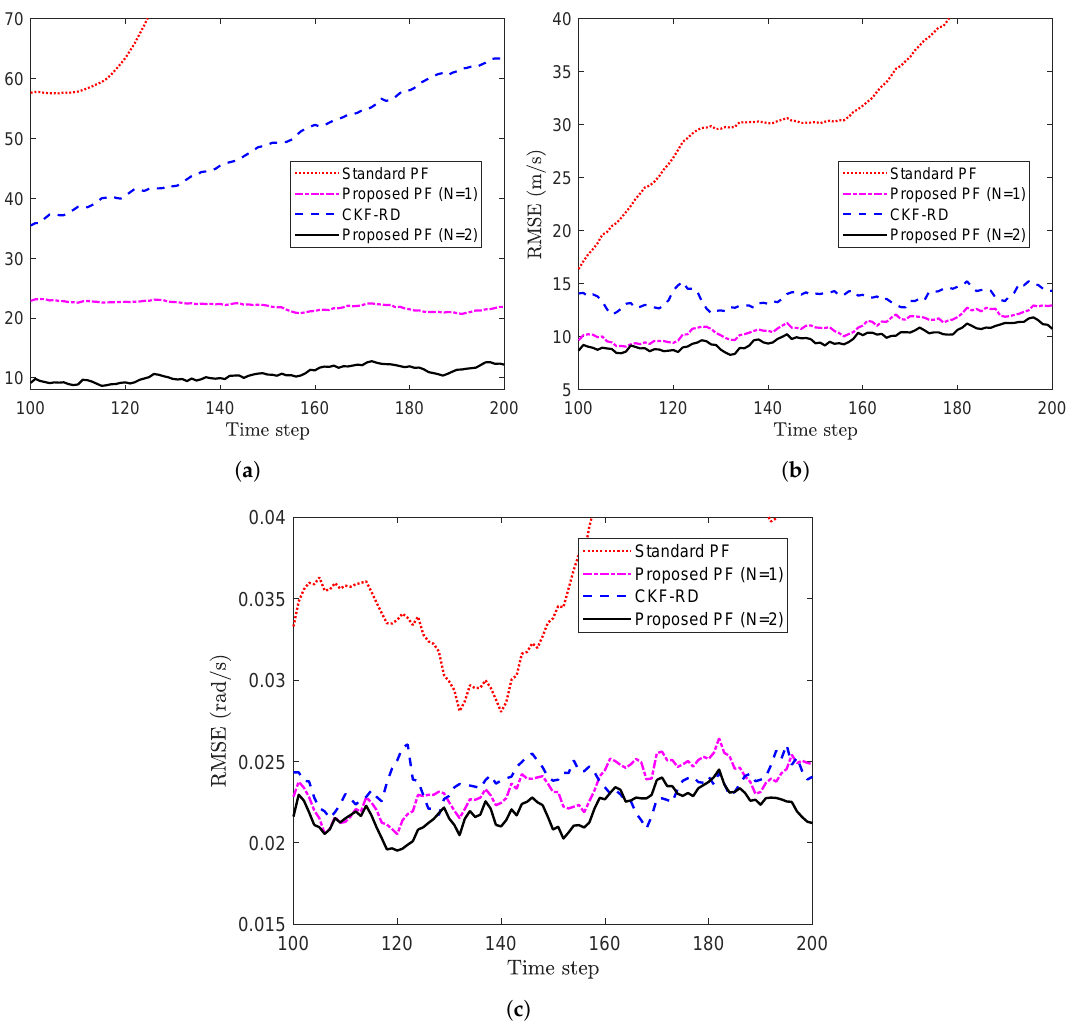
Figure 11. RMSE vs. time steps considering p = 0.5. ( a ) RMSE of position ( b ) RMSE of velocity ( c ) RMSE of turn rate (Problem